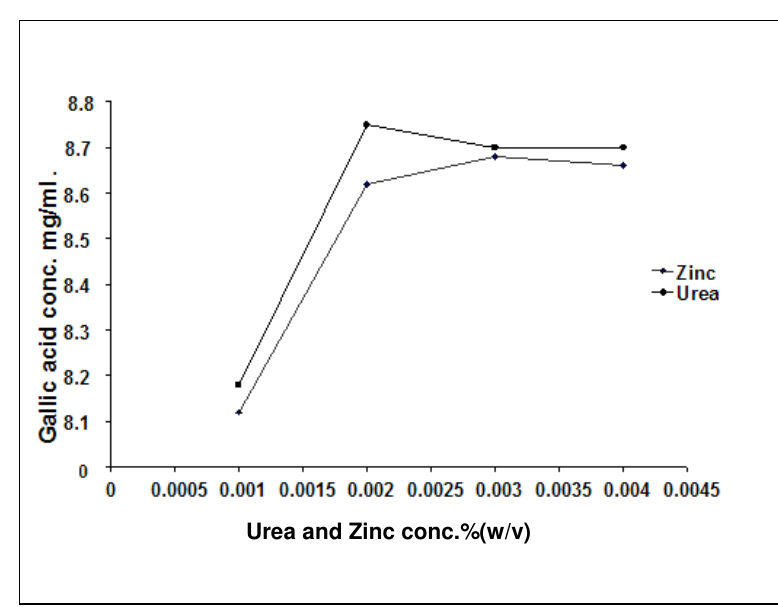
Figure 3. Effect of urea and zinc conc. on gallic acid production.